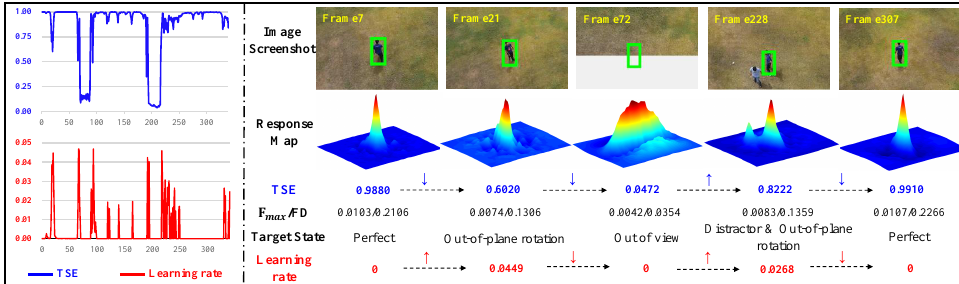
Figure 3. Illustration of the auto-learning strategy. The green box shows the tracking